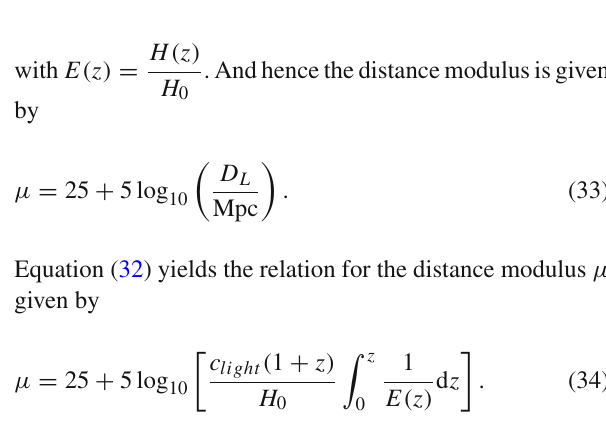
Fig. 7 The variation in the squared sound speed v 2 s with redshift z for the closed universe, in units when M 2 p = 1 , H 0 = 67 . 9. In order to be consistent with data, we now imposed (cid:2) d ( x = − ln ( 1 + z ) = 0 ) = (cid:2) d [ 0 ] = 0 .